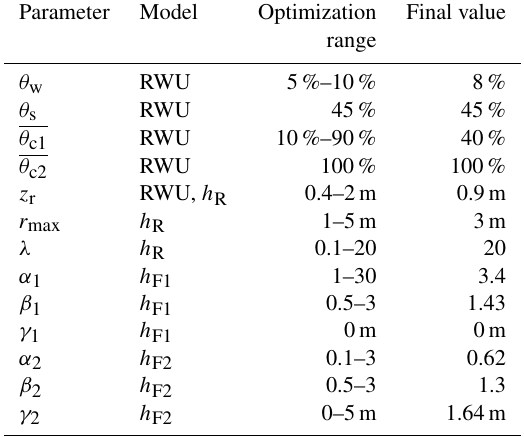
Table 2. The different parameters used for RWU modeling and the transfer functions used to transform δ RWU into δ R ( h R , h F1 ) and δ R into δ H ( h F2 ). Meanings of the parameters are listed in Table